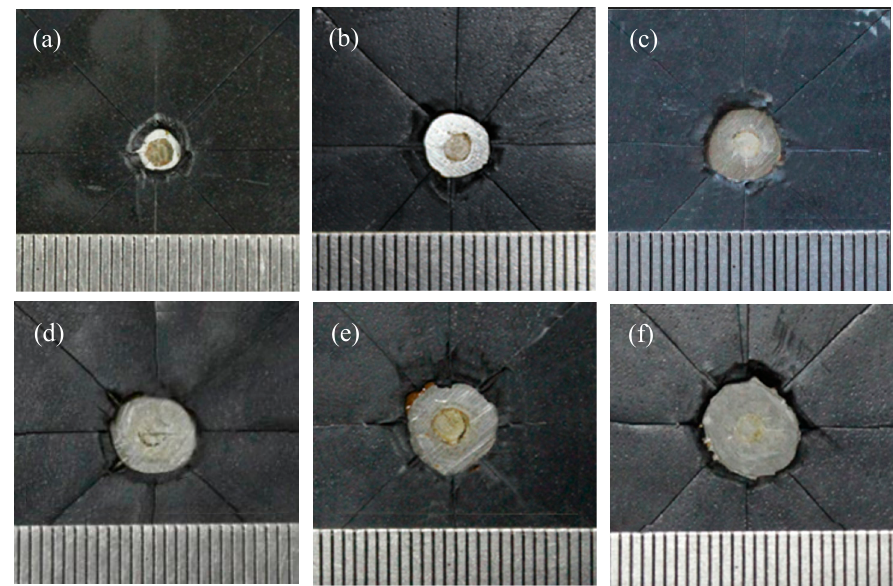
Figure 8. Photographs of the cathodic disbondment of the 3PE coating of the X80 steel samples under DC cathode current densities equal to ( a ) 0 A/m 2 , ( b ) 20 A/m 2 , ( c ) 40 A/m 2 , ( d ) 60 A/m 2 , ( e ) 80 A/m 2 , and ( f ) 100 A/m 2 .